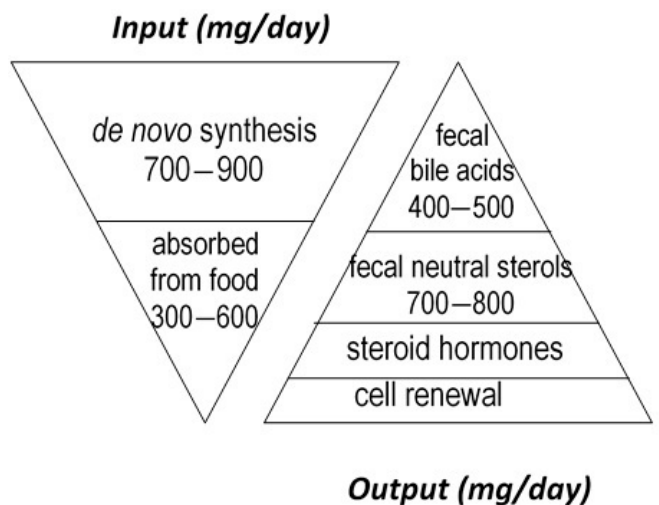
Figure 1. Estimation of daily cholesterol input and output in the healthy adult.